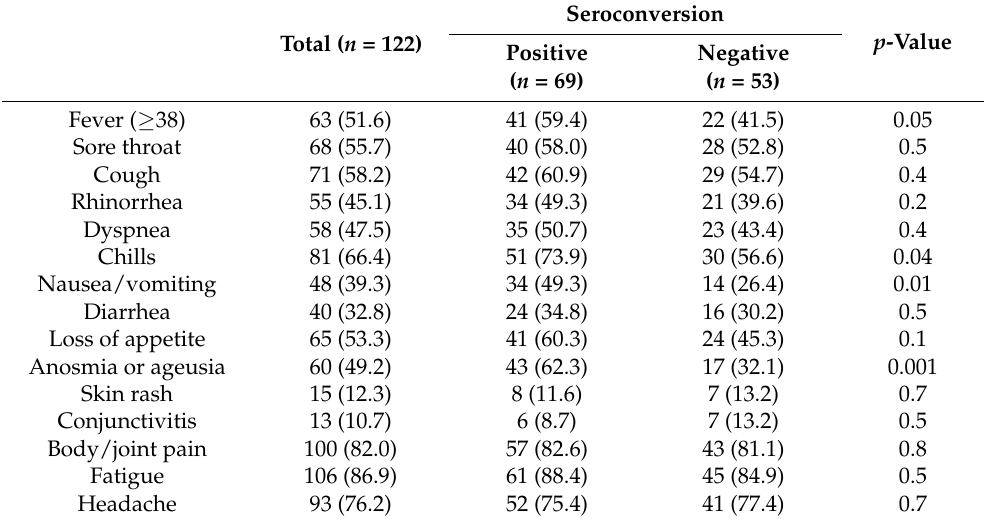
Table 3. Frequency of reported symptoms in preceding months in HCWs based on seropositivity.